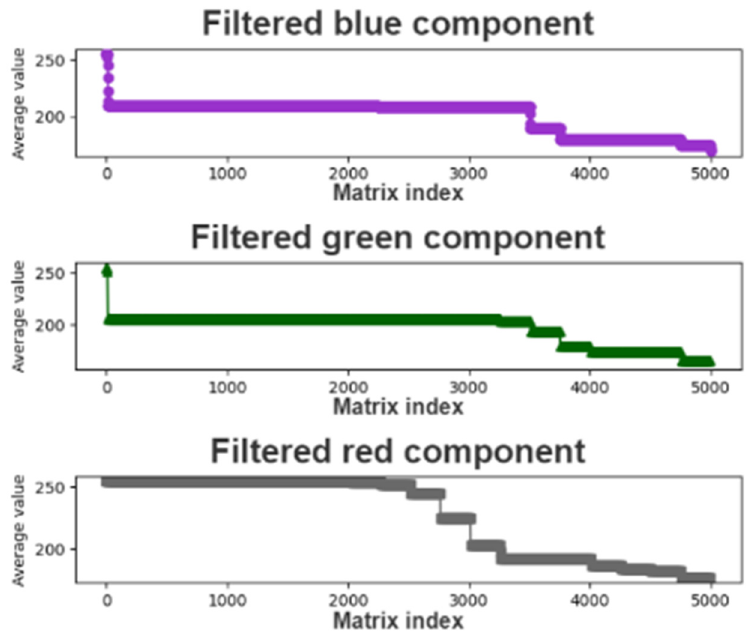
Figure 16. Plot of the mean color component matrix obtained after low-pass filtering.